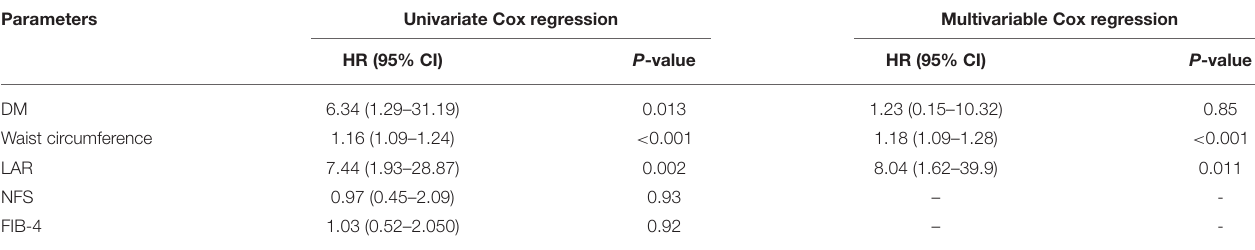
TABLE 4 | The risk of portal vein thrombosis development in the univariate and multivariable Cox regression models in the studied patients.